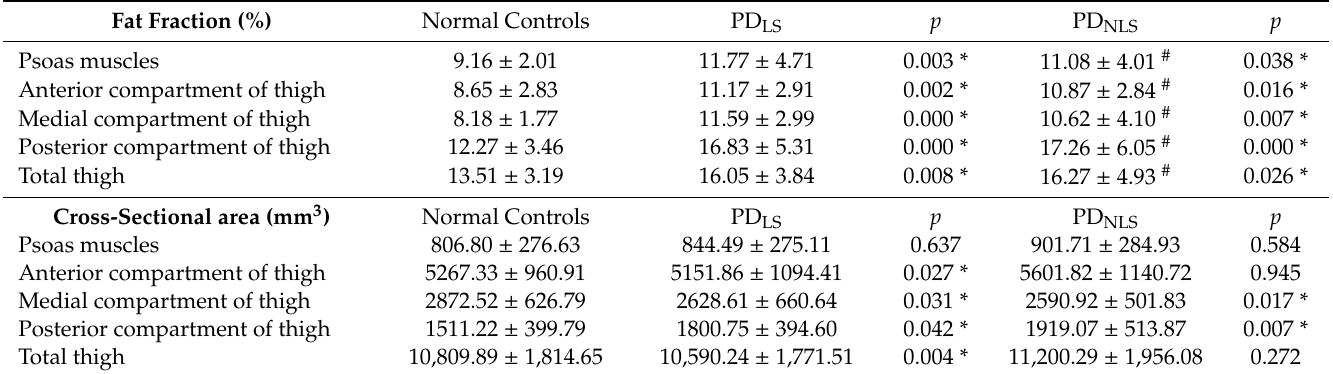
Table 3. Comparison between fat fraction and cross-sectional areas (mm 3 ) of the lesion and non-lesion side in PD patients and normal